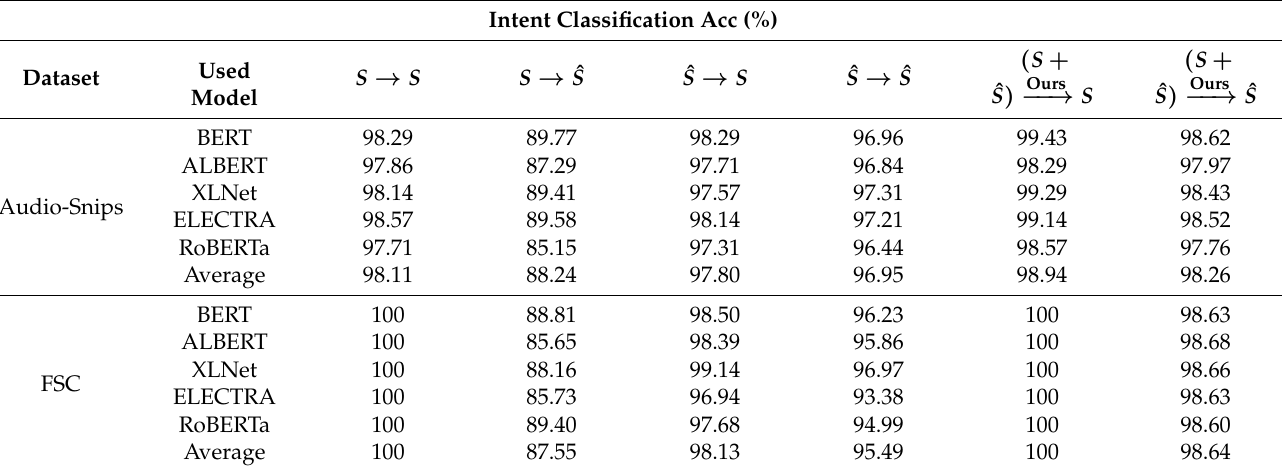
Table 4. Experiment results on both the Audio-Snips dataset and FSC dataset. Intent Classification Acc